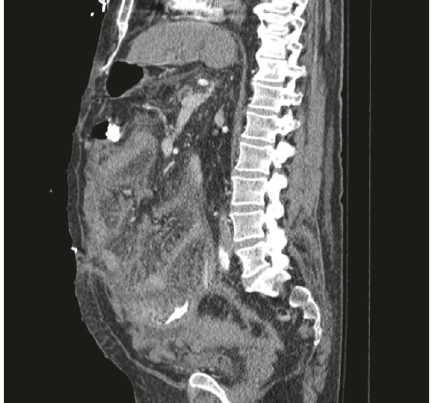
Figure 2: Mesenteric stranding and peritoneal thickening diagnos- tic for peritoneal lymphoma.